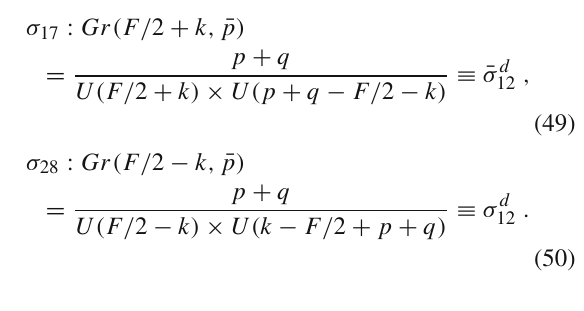
is represented 3